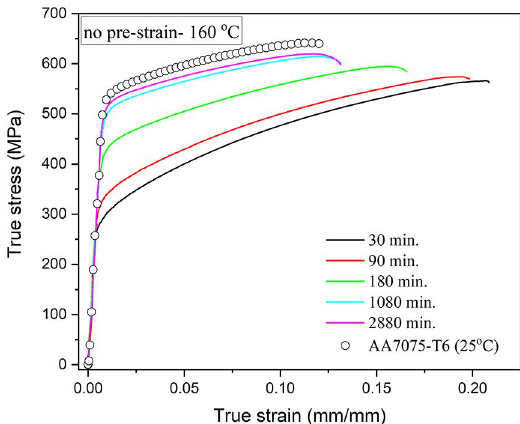
Figure 10. True stress vs. true strain for different aging time at 160 ºC (no pre-strain)